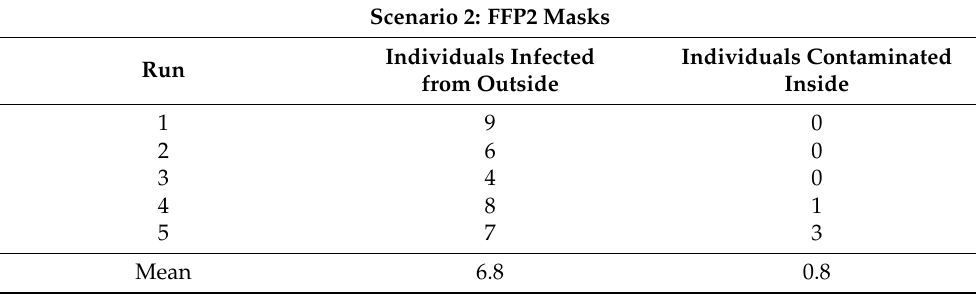
Table 10. Scenario 2